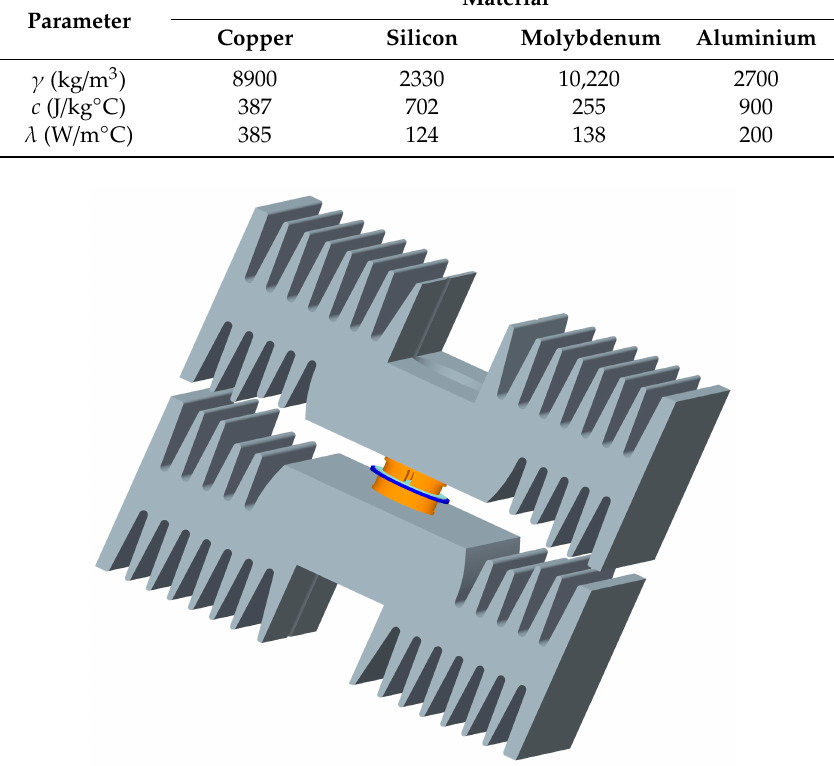
Figure 6. Thermal model of the power assembly thyristor—heatsinks.